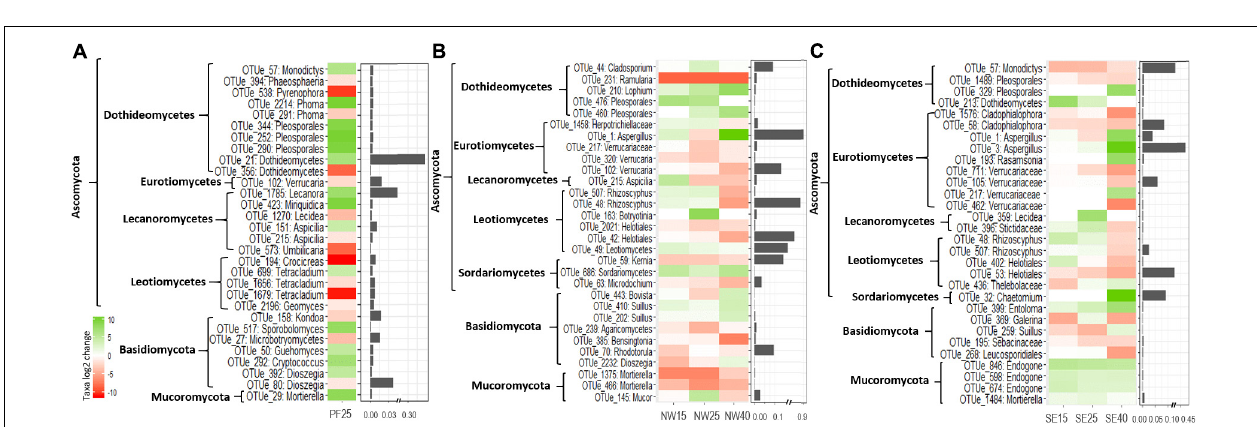
FIGURE 5 | The most pronounced changes in the relative abundance (log2-fold change) of bacterial OTUs during the incubation for (A) PF soil: 4 ◦ C compared with 25 ◦ C; (B) NW soil: 4 ◦ C compared with 15, 25, and 40 ◦ C; and (C) SE soil: 4 ◦ C compared with 15, 25, and 40 ◦ C. OTU names are given at the deepest successful classification and then grouped according to phylum. Proteobacteria are defined to the class level. Changes are displayed by a red (negative) to green (positive) color range and bar plots show relative abundance (%) during acclimation.